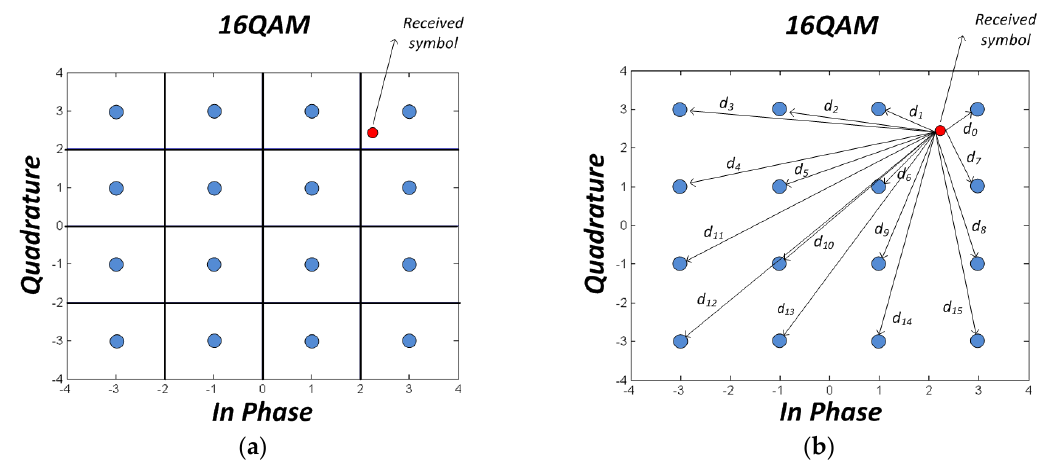
Figure 8. Two different implementation approaches of the symbol decision circuit corresponding to the best- and worst-case scenarios in terms of computational complexity. ( a ) Decision based on I and Q levels comparison. ( b ) Decision based on distance calculation to all the points in the constellation.